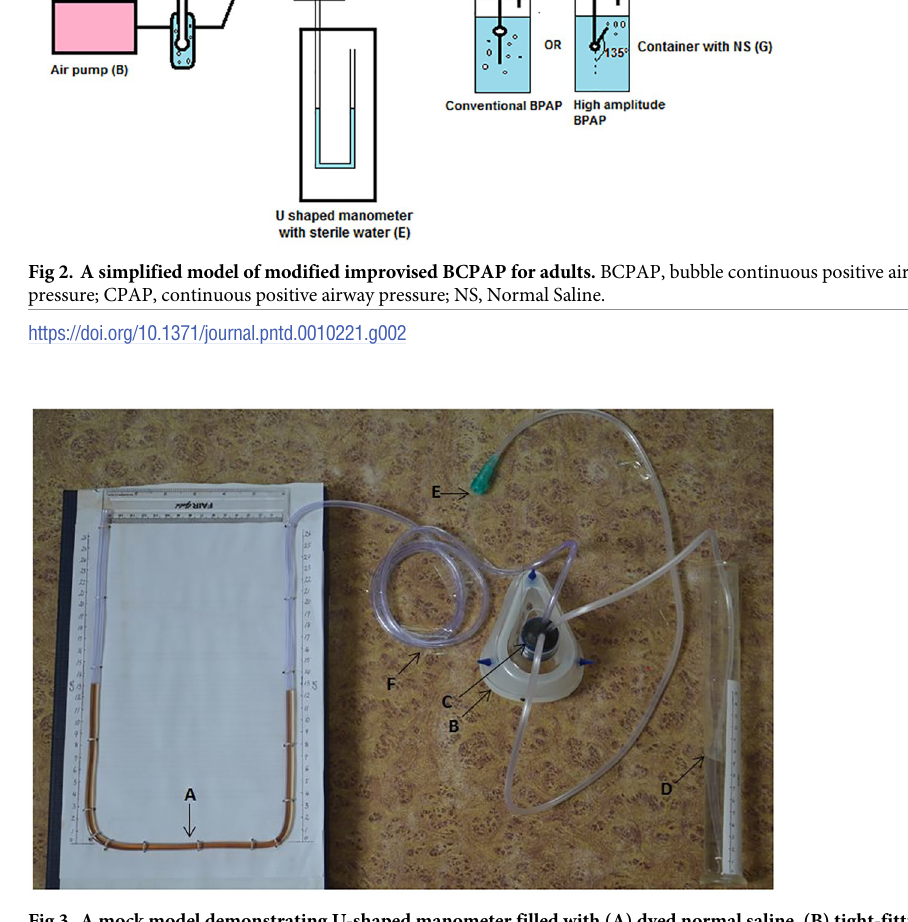
Fig 3. A mock model demonstrating U-shaped manometer filled with (A) dyed normal saline, (B) tight-fitting face mask, (C) fast-curing epoxy putty, (D) container containing NS, (E) port through which blended air can be passed, (F) and plastic tubing. NS, Normal